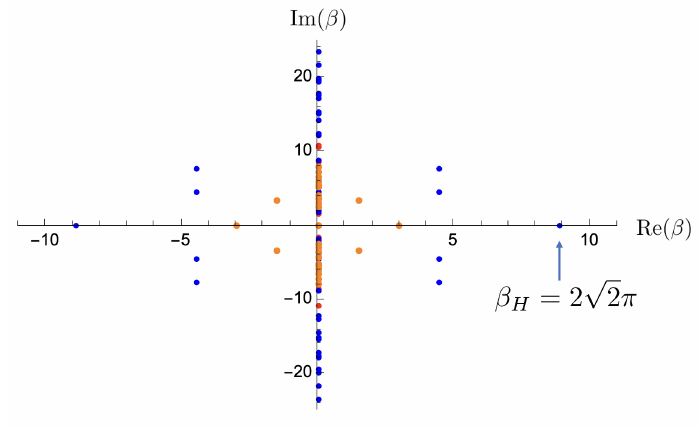
Figure 18 . We plot the distributions of the complex singularities for Type II string theories ( α 0 = 1 ), with | w | ≤ 3 , | n | ≤ 2 , N L ≤ 4 , N R ≤ 4 . The blue dots ( w = 1 ) and the orange dots ( w = 3 ) correspond to solutions of (B.6). The red dots come from